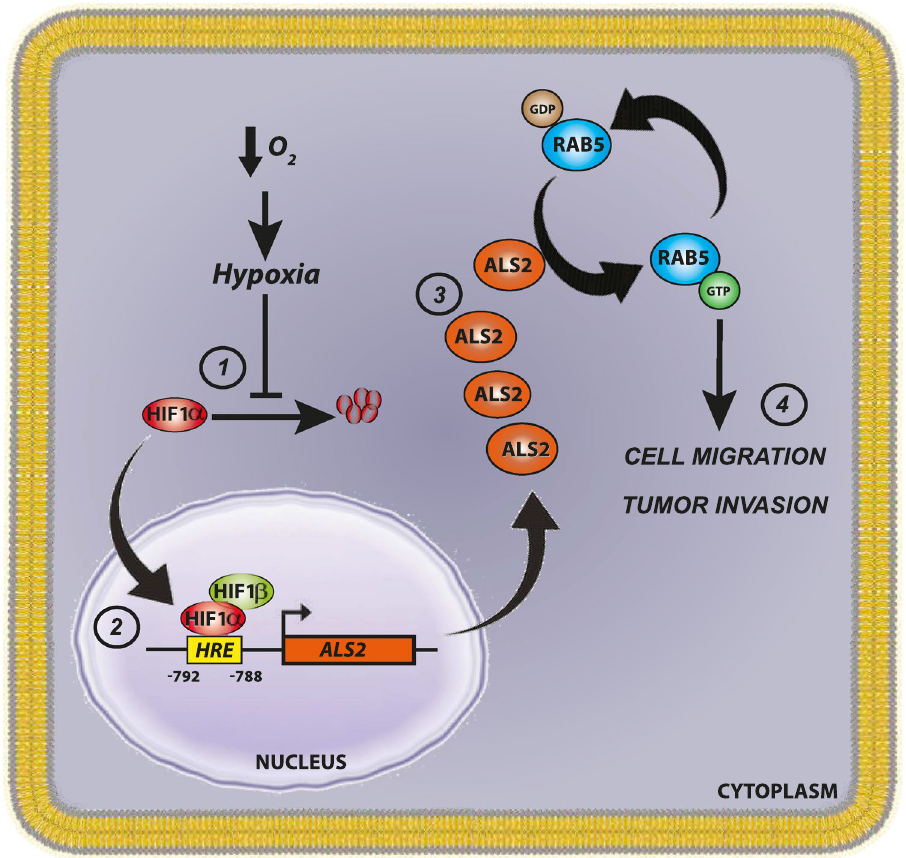
Figure 6. Proposed model. In hypoxia, HIF-1α stabilizes and heterodimerizes with HIF-1β allowing the transcription of ALS2 via binding to the HRE located within the proximal promoter (− 792 to − 788) of